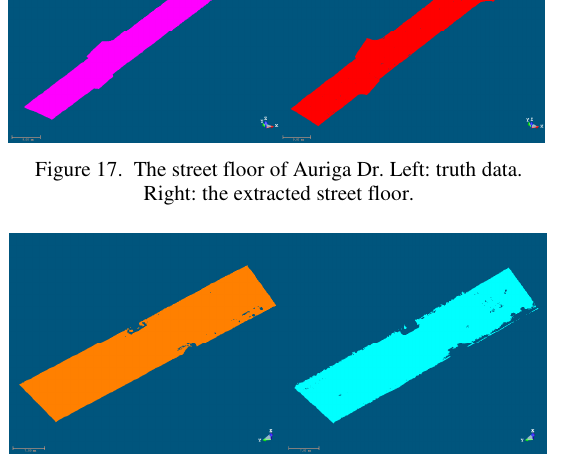
Figure 18. The street floor of Dalhousie St. Left: truth data. Right: the extracted street